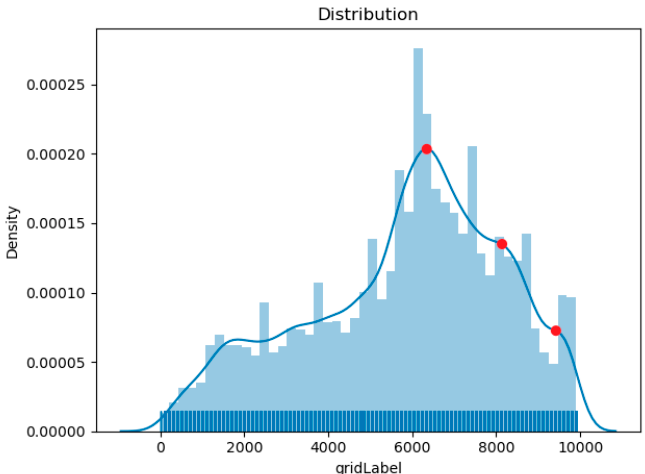
Figure 8. The gridded area shows the number of crossings recorded by each grid in the form of frequency.